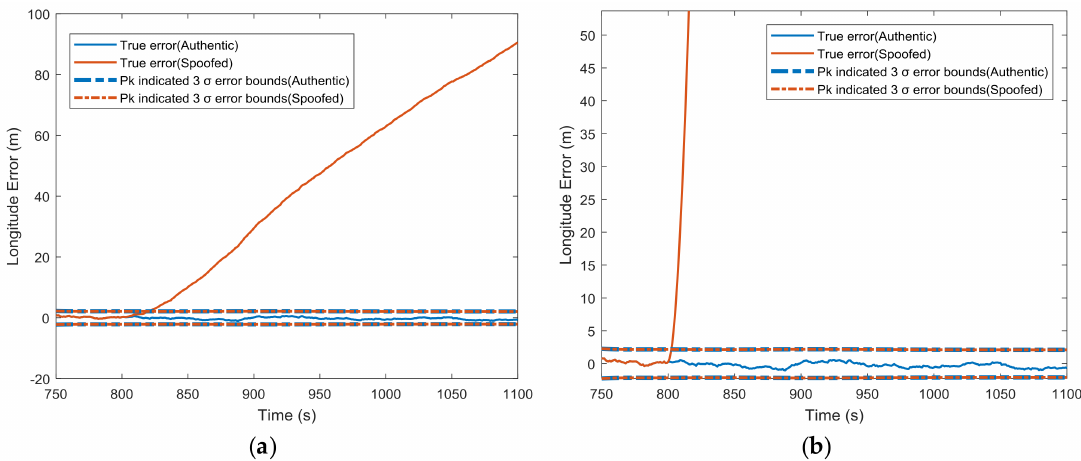
Figure 4. Error covariance matrix ( P k )-indicated and true position errors under normal conditions and ( a ) 0.3 m/s synchronized spoofing attack; ( b ) 12.4 m/s synchronized spoofing